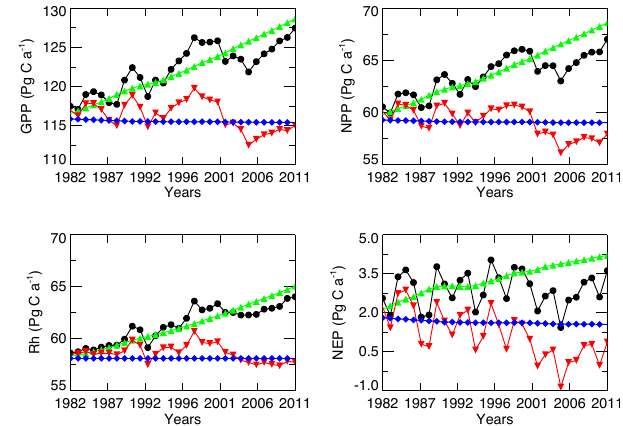
Figure 5. Global total fluxes of GPP, NPP, Rh (heterotrophic res- piration), and NEP from different sensitivity simulations with all forcings (black), meteorology alone (red), CO 2 alone (green), and land use change alone